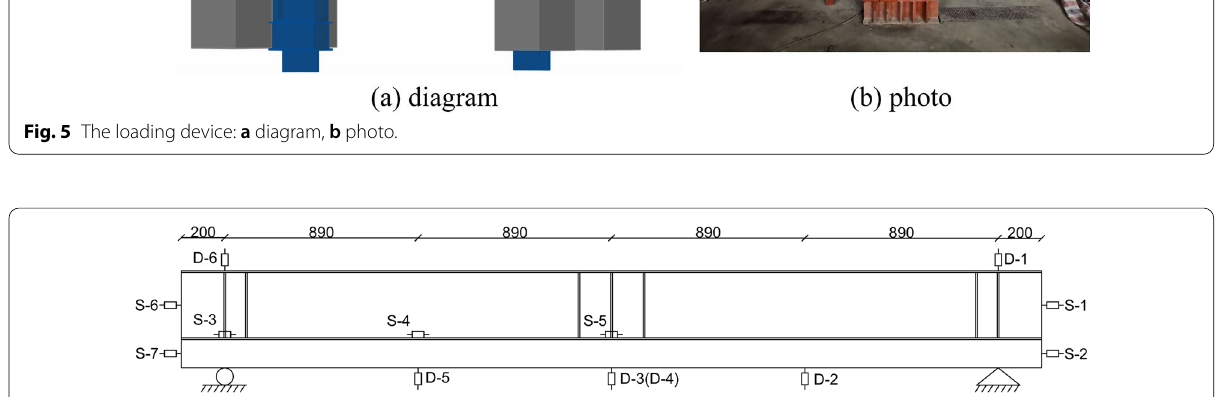
Fig. 6 Displacement meter position.